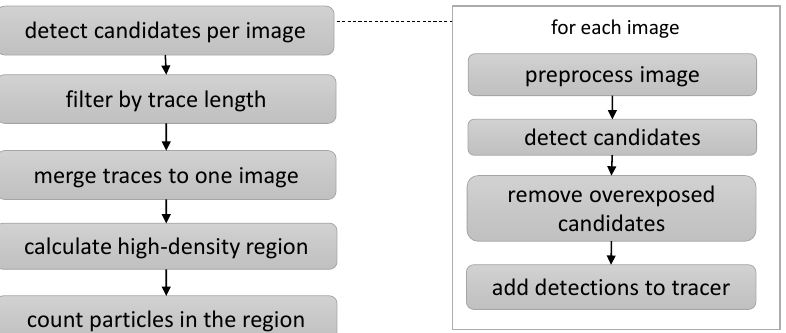
Figure 9. Visualization of the focus region detection for one motor position. By analyzing multiple frames and linking the detections of individual images over time to form traces, improved stability can be achieved.